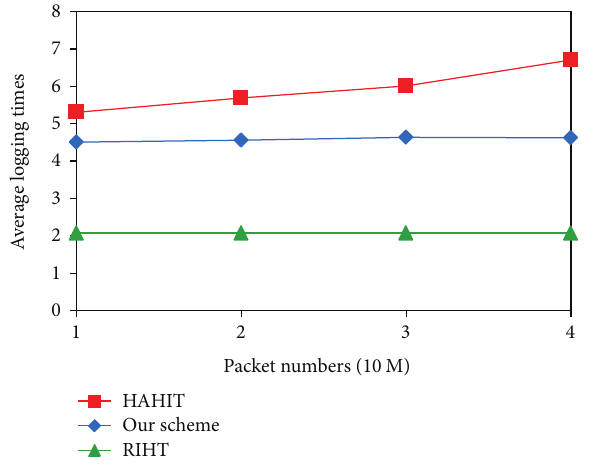
Figure 6: Comparison of logging times.